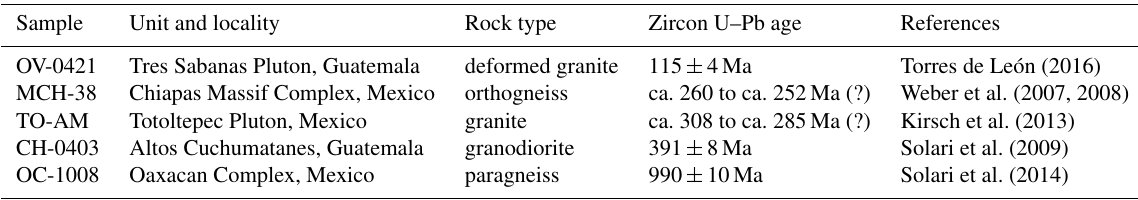
Table 1. Lithology, locality, and zircon U–Pb data for the selected experimental rock samples.